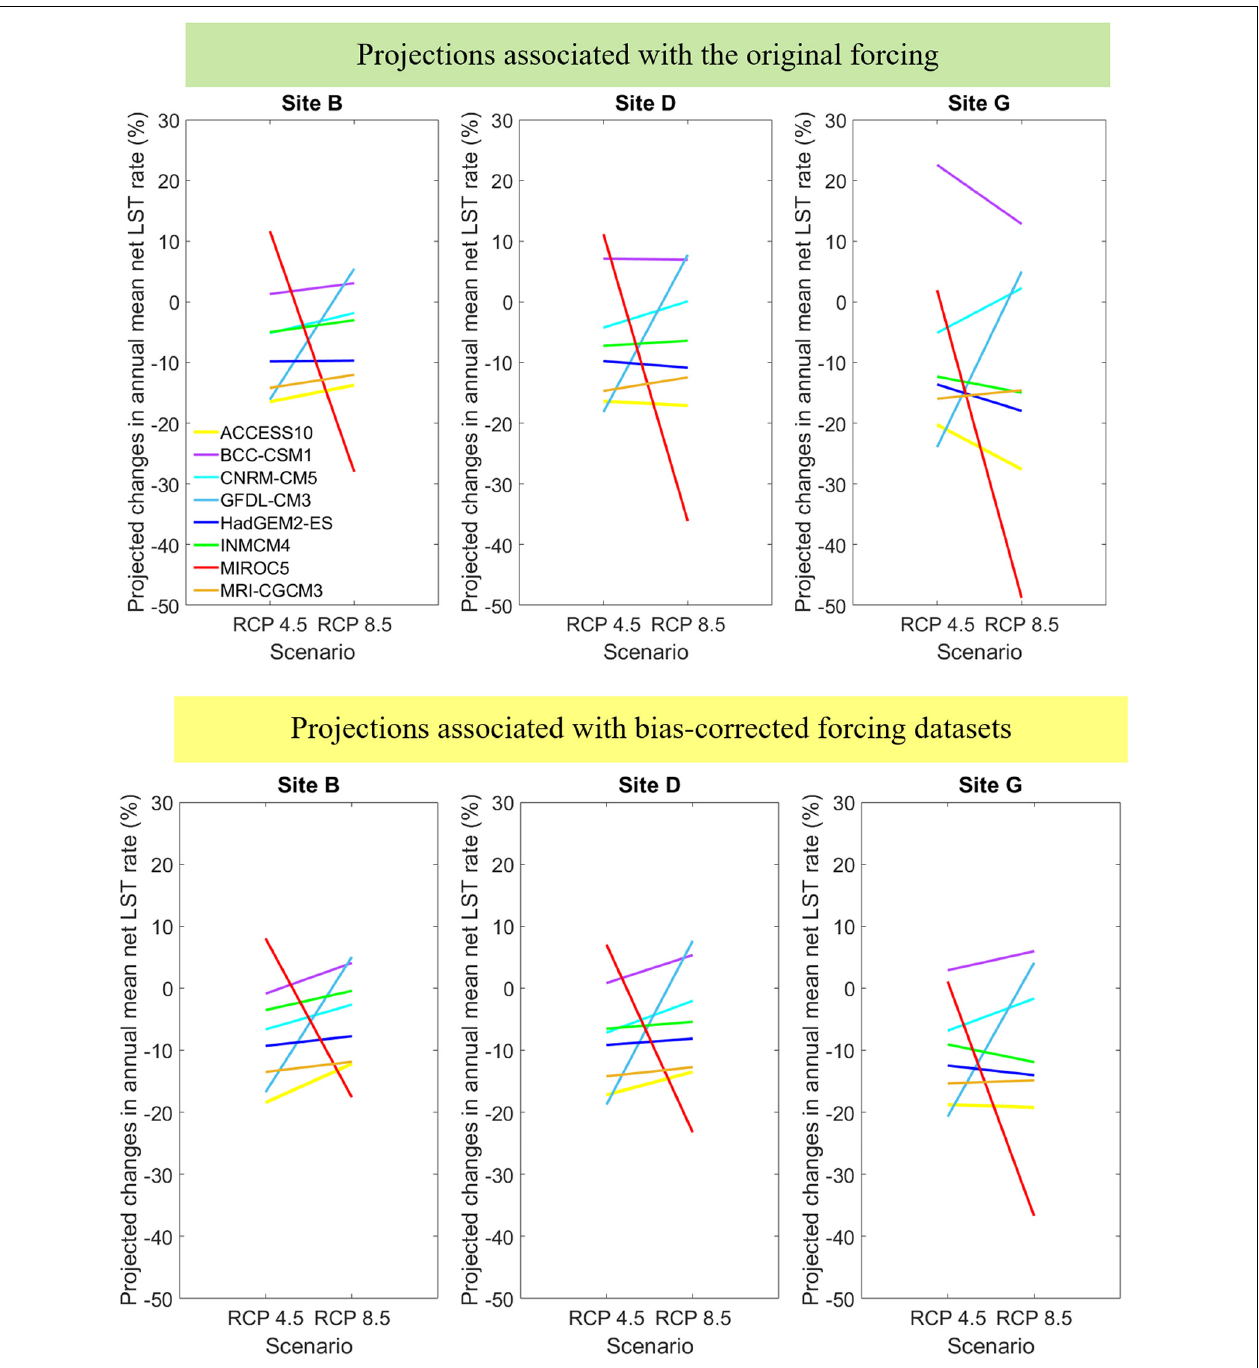
FIGURE 9 | The role of interactions of GCM-Ws with emission scenarios on the projection of LST rates; Projections associated with using the original forcing datasets (top panel) and bias-corrected datasets (bottom panel); The projected changes in LST rate, here, were obtained from the average of all LST models’ outputs.